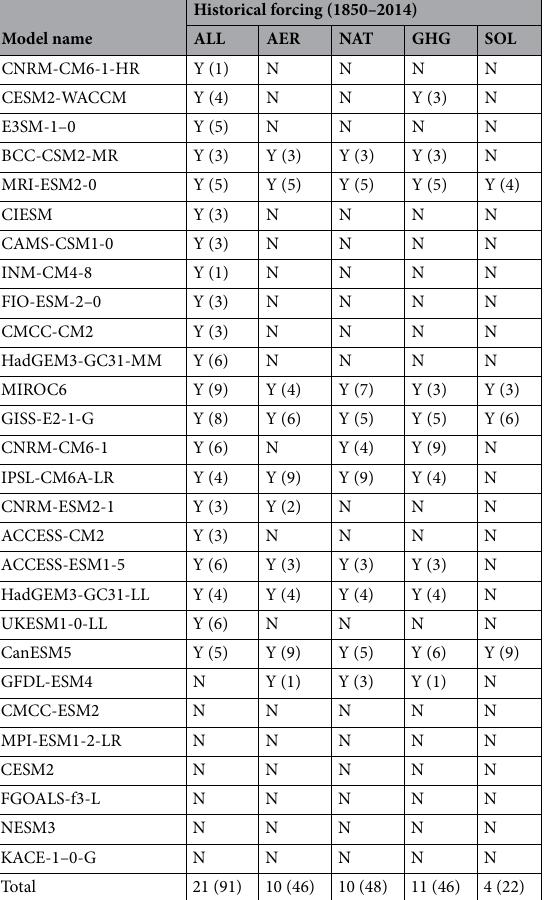
Table 1. Models used in the study for historical simulations (Y = ‘yes’ and ‘N’ = no). The numbers in parenthesis represent the ensemble sizes of the corresponding